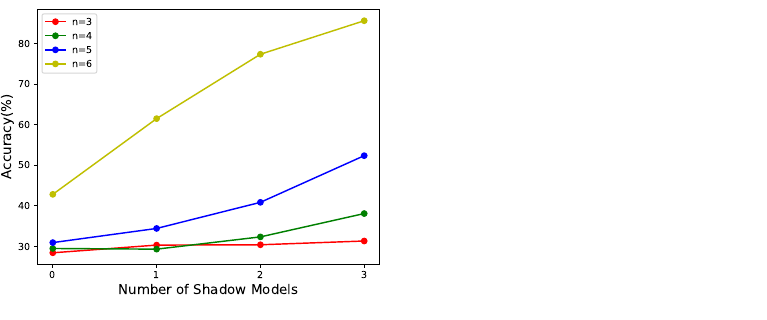
Figure 8. The relationship between the performance of reconstructed model and number of shadow models with weight of 10 for different determined sharing